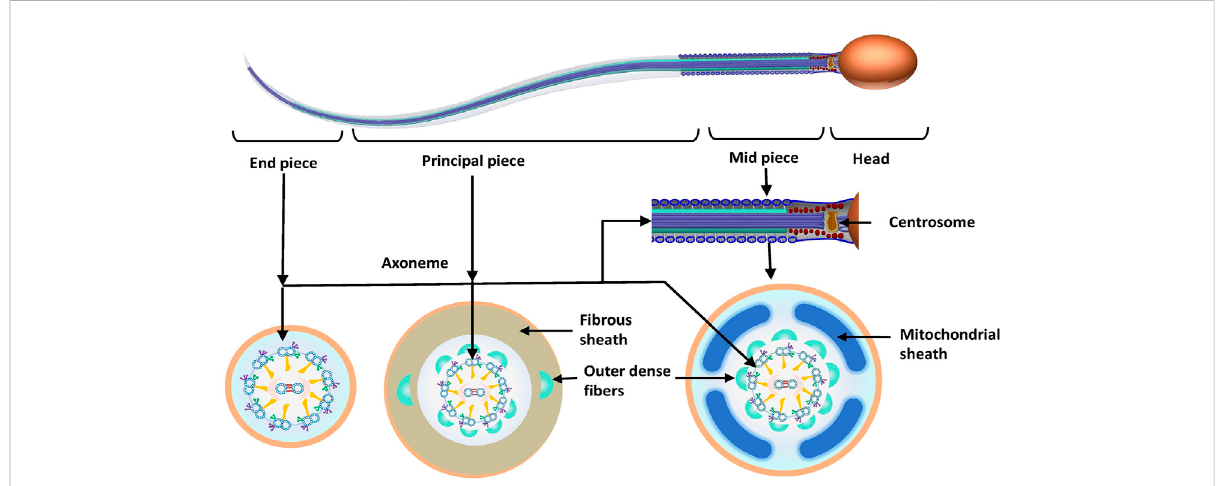
FIGURE 1 Normal sperm morphology and ultrastructure. Sperm is divided into the sperm head and fl agellum. The fl agellum is subdivided into the following three parts: midpiece, principal piece and end piece. The centrosome is divided into proximal and distal centrioles, which attach to the basal plate at the implantation fossa and form the axoneme. The axoneme crosses through the entire fl agellum. In the midpiece and principal piece, the axoneme is surrounded by outer dense fi bers. The midpiece also consists of a mitochondrial sheath surrounding the axoneme, which is replaced by the fi brous sheath in the principal piece. There is no periaxonemal structure in the end